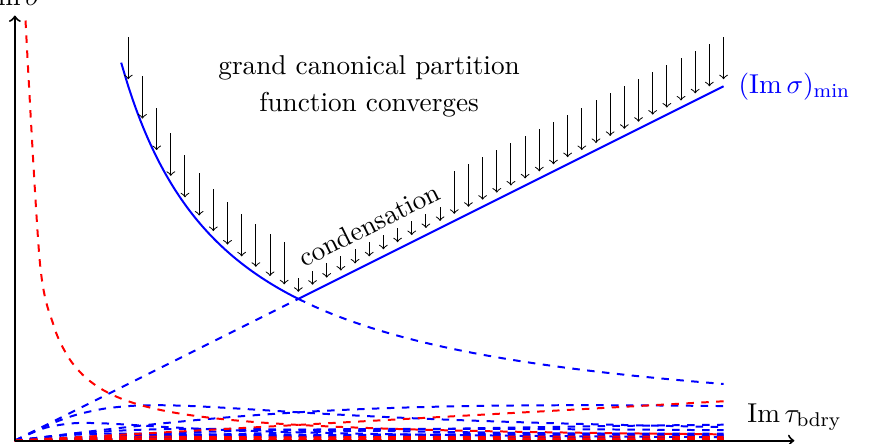
Figure 8 . The behaviour of the grand canonical torus partition function for purely imaginary τ bdry . Blue lines correspond to poles with M = 1 and red lines to poles with M = 3